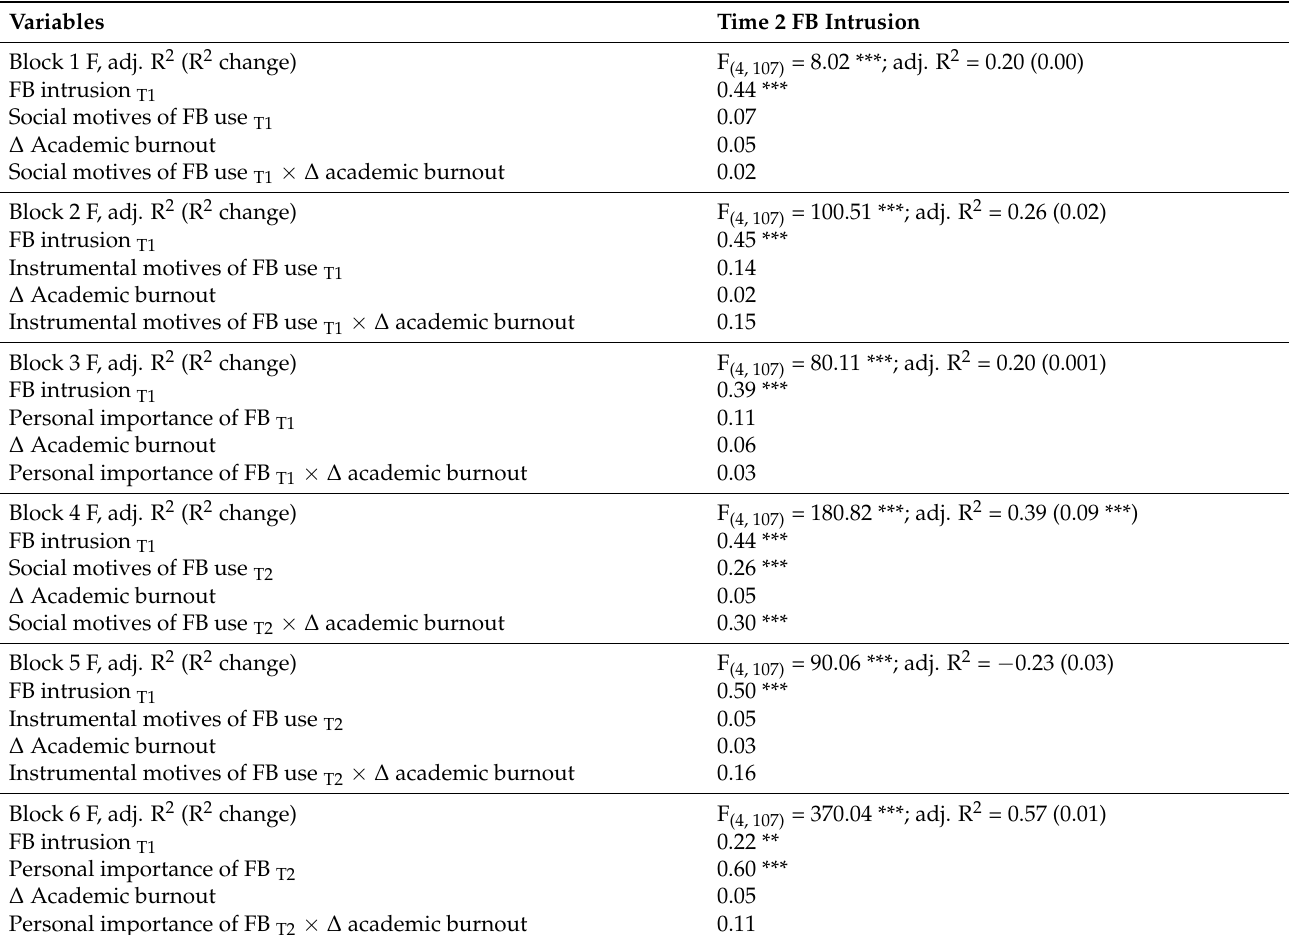
Figure 1. The effects of changes in academic burnout on the association between social motives for FB use and FB intrusion, both measured at time 2. Table 2. Results of the hierarchical regression analyses examining the effects of changes in academic burnout and FB motives and importance measured at times 1 and 2 on FB intrusion measured at time 2.